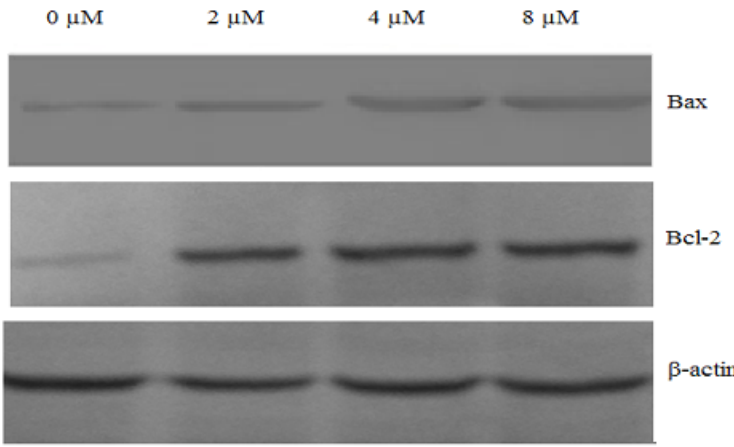
Figure 8. Chamaejasmine-mediated up-regulation of Bax and downregulation of Bcl-2 by western blotting assay, A549 cells were treated with chamaejasmine (0, 2, 4, 8 µM) for 48 h, respectively. The test was repeated three times and representative blots are shown. β -actin served as a loading